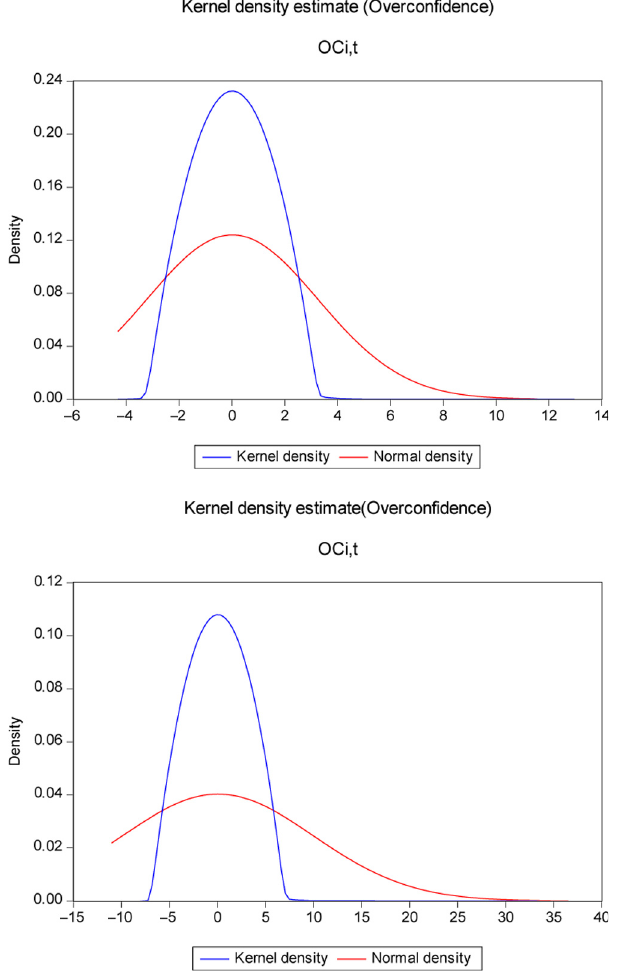
Figure 5. Non-normality